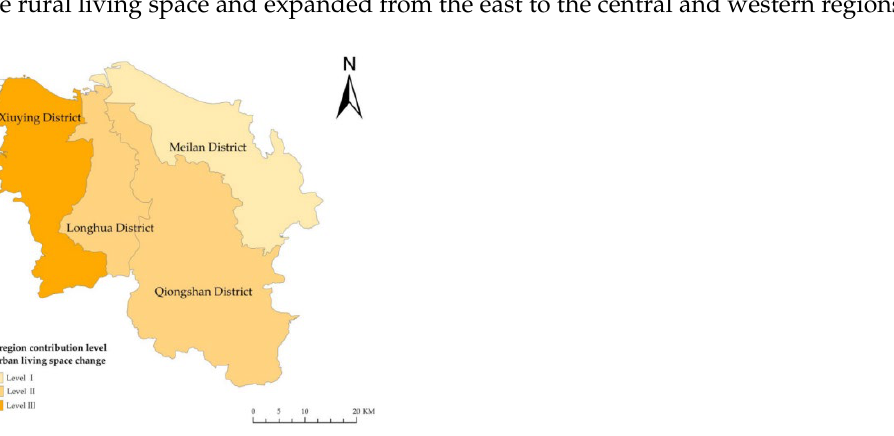
Figure 6. The sub-region contribution level of urban living space conversion in Haikou, China, from 2009 to 2018.